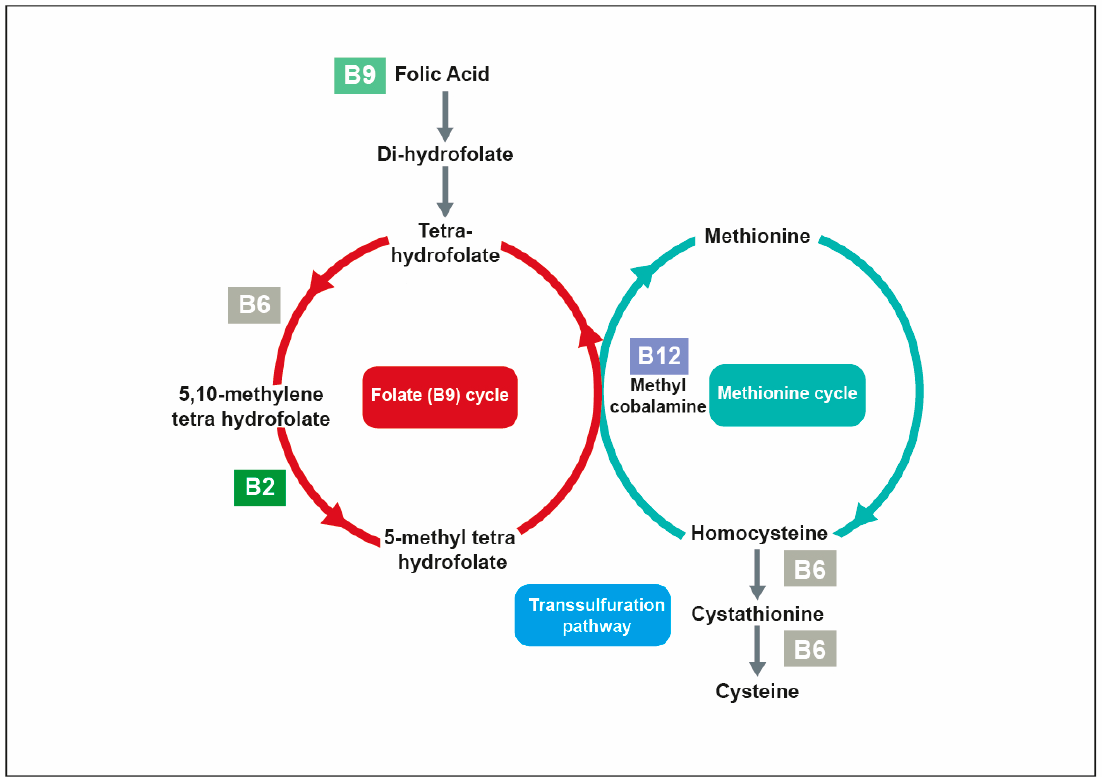
Figure 2. Metabolic and functional interactions of vitamins B9, B12 and B6.